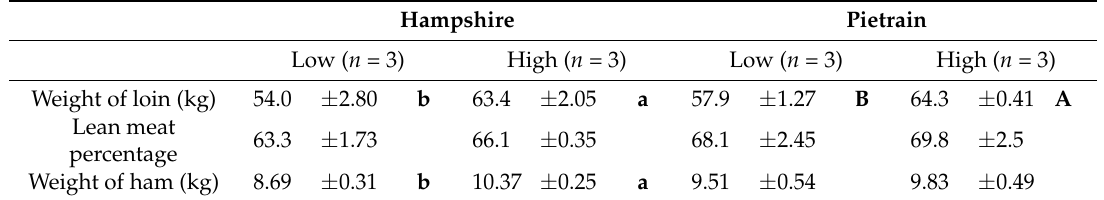
Table 7. The differences in muscle weight observed between the analysed groups for both breeds. Hampshire